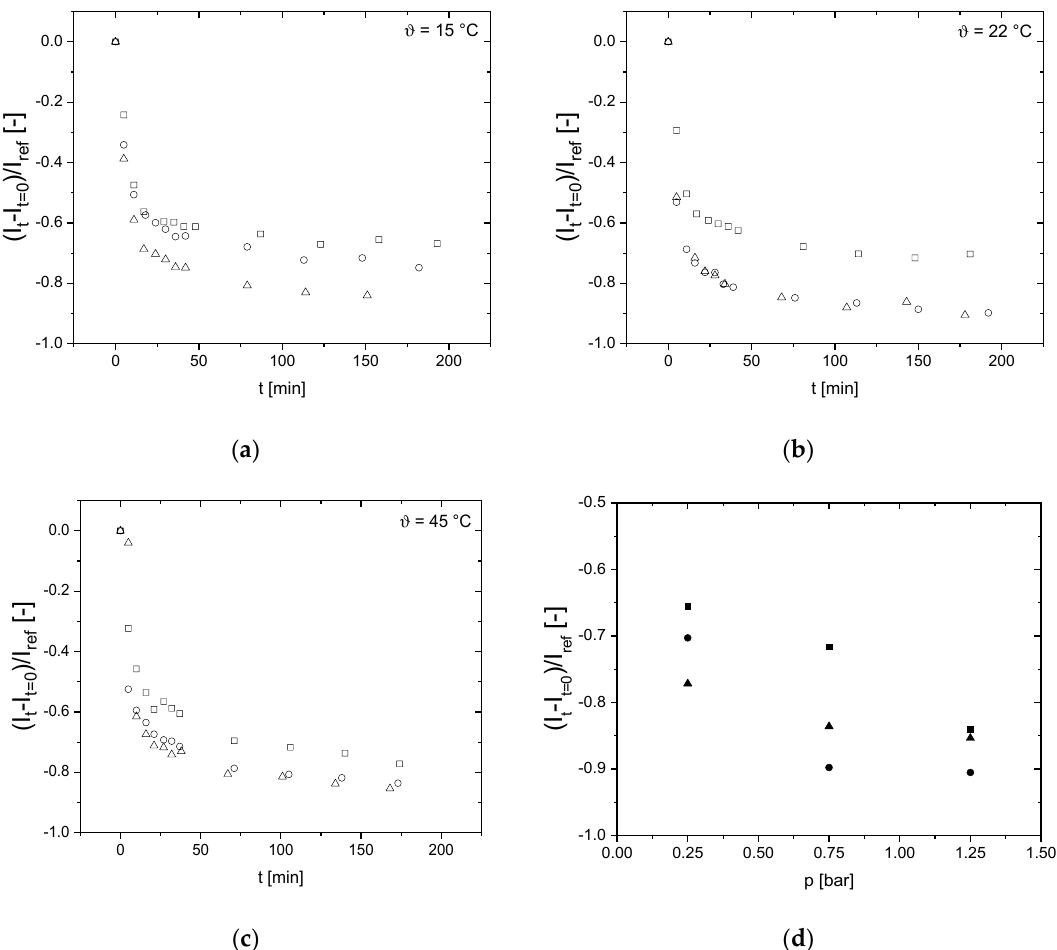
Figure 8. Reduced signal intensity of the voxel directly at the inner surface of the membrane as a function of filtration time t for ( a ) ϑ = 15 °C ( b ) ϑ = 22 °C and ( c ) ϑ = 45 °C by the concept described in [25] and measured for p = 0.25 bar (squares), p = 0.75 bar (circles) and p = 1.25 bar (triangles). ( d ) Comparing the reduced signal intensity at the selective layer of the membrane for t = t max indicates that with increasing pressure and temperature the deposit found in MRI to be more compact. Temperature was set to ϑ = 15 °C (filled squares), ϑ = 22 °C (filled circles) and ϑ = 45 °C (filled triangles).